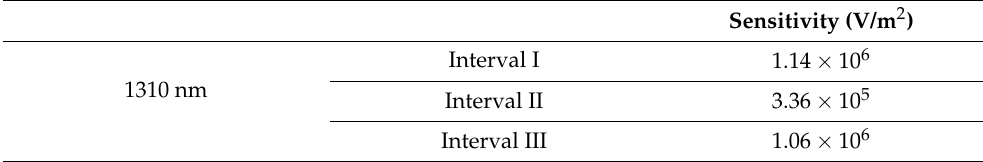
Table 4. Sensor sensitivity for λ = 1310